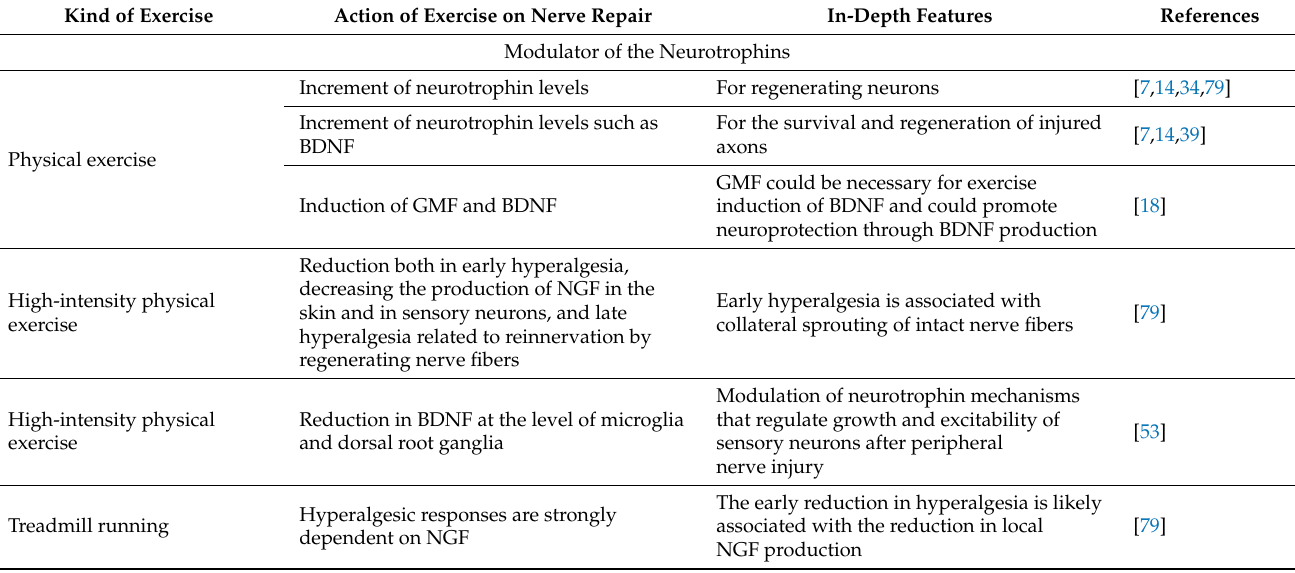
Table 5. Mechanisms of action of controlled physical exercise on nerve repair and